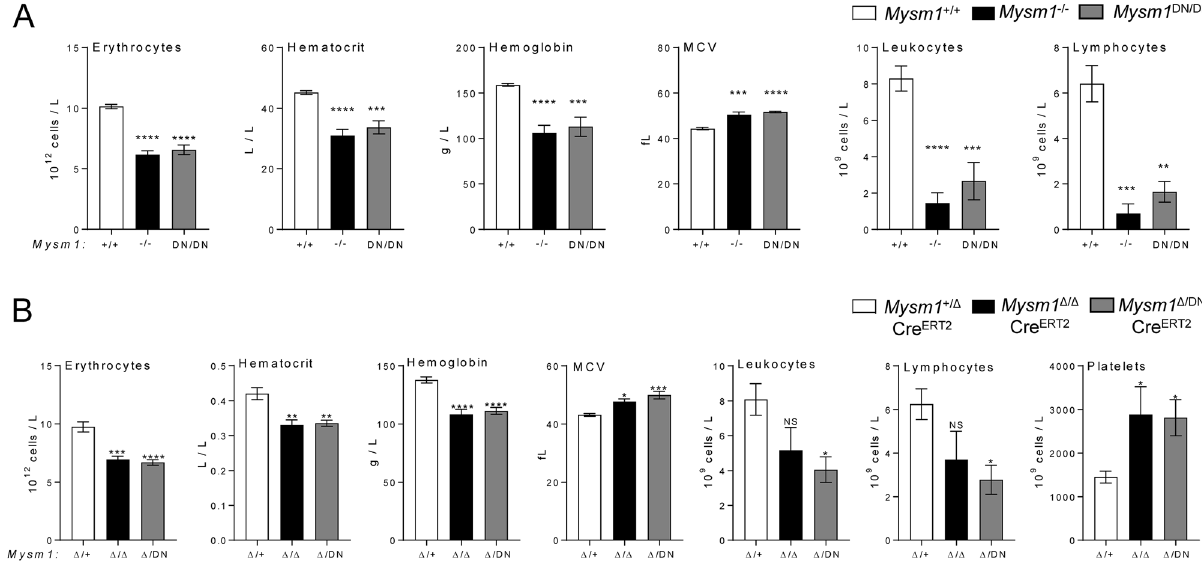
Figure 2. Hematologic dysfunction in the mouse models with the loss of MYSM1 DUB catalytic activity. Hematology analyses were conducted on the blood of ( A ) Mysm1 +/+ , Mysm1 −/− , and Mysm1 DN/DN mice, and ( B ) Cre ERT2 -transgenic tamoxifen-treated mice of Mysm1 fl/+ , Mysm1 fl/fl , and Mysm1 fl/DN genotypes. Data is from ( A ) 3–8 mice per genotype consolidated from two independent experiments, or ( B ) 5–6 mice per genotype consolidated from two independent experiments. Bars represent means ± SEM; statistical analysis with ANOVA comparing each group to the control, * p < 0.05, ** p < 0.01, *** p < 0.001, NS—not significant; MCV—mean corpuscular